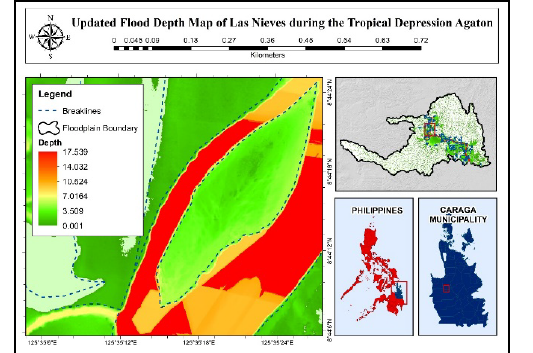
Figure 16 . Flood Depth Map of Las Nieves during the Tropical Depression Agaton using the Updated UAS-based DTM